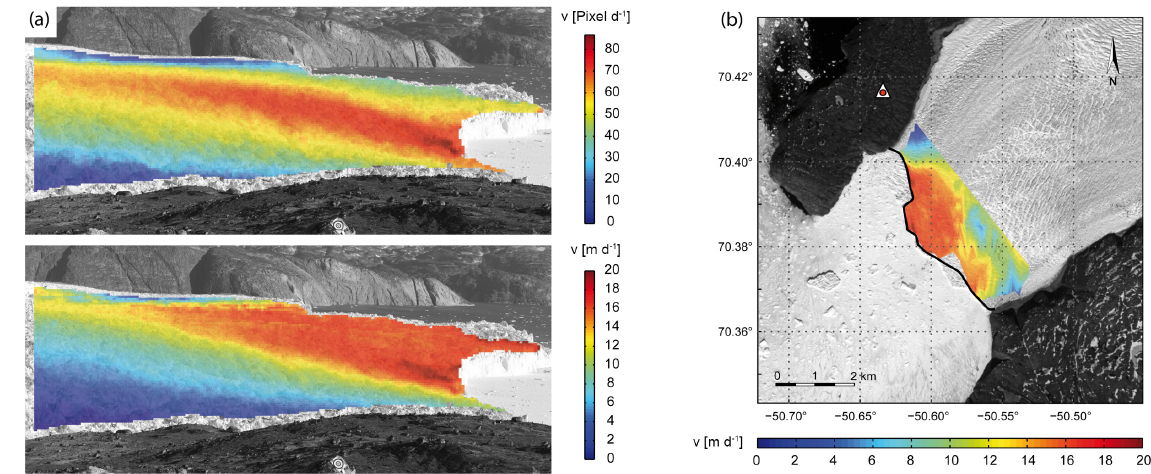
Figure 11. Result of scaling (a) and geo-referencing (b) at Støre Qarajaq glacier. The figure shows the colour-coded superposition of velocity values derived from measured trajectories. They are shown as unscaled values in image space ( a , top) and scaled values transferred into object space ( a , bottom), as well as geo-referenced values that can be overlaid on satellite images (b) .